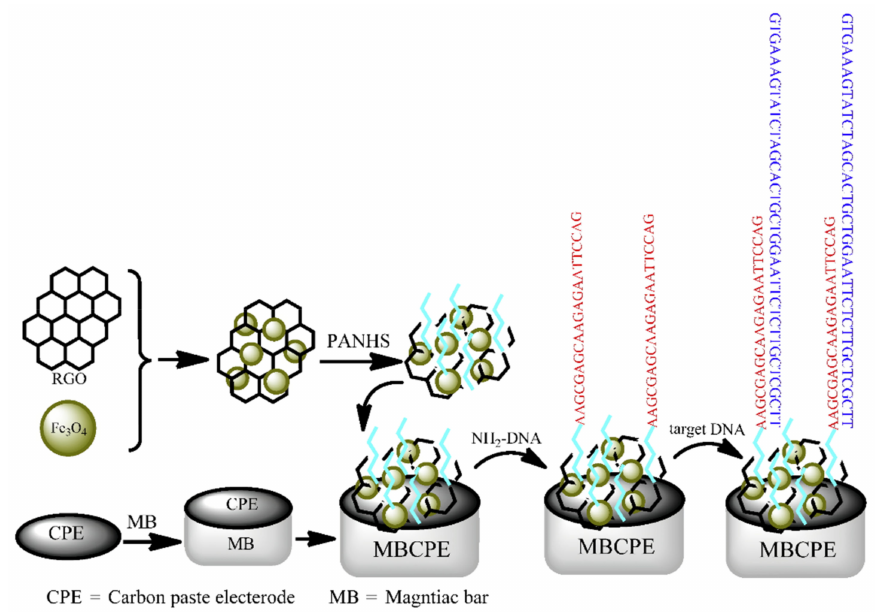
Figure 3. Schematic representation of the modified electrochemical biosensor based on MBCPE/Fe 3 O 4 -RGO/PANHS platform. Reprinted from [66] with permission of Elsevier provided by Copyright Clearance